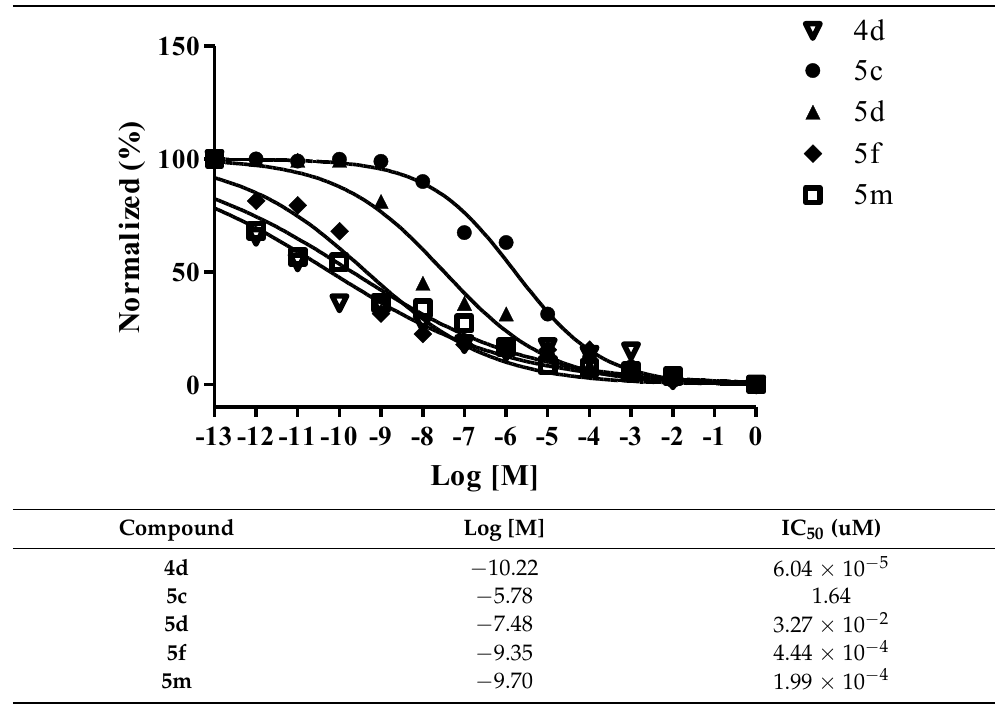
Table 2. IC 50 (uM) values of the compounds 4d, 5c, 5d, 5f , and 5m on suppression of IL-6 mRNA Table 2. IC 50 (uM)valuesofthecompounds 4d , 5c , 5d , 5f , and 5m onsuppressionofIL-6mRNA expression.